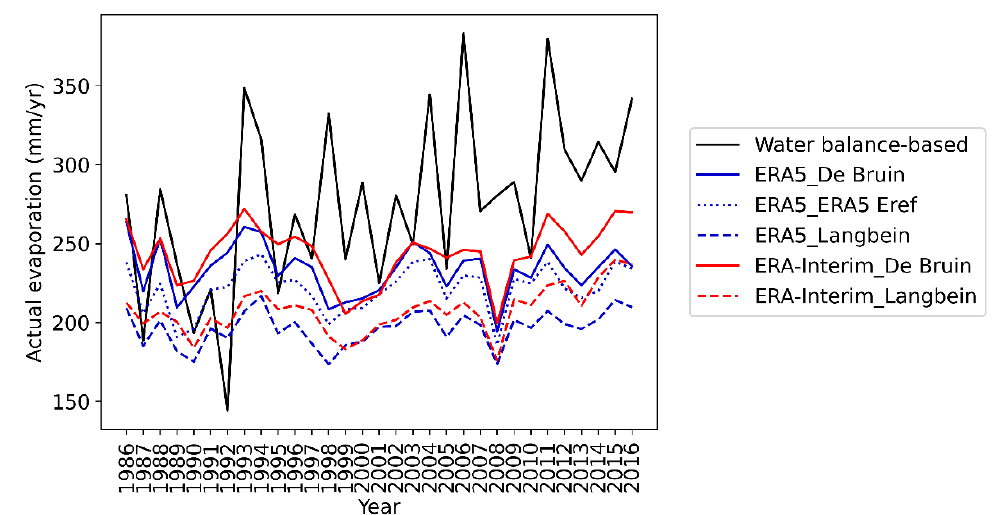
Figure 10. Estimated actual evaporation (Eact) calculated by the GlobWat model using different weather datasets and reference evaporation (Eref) methods against the observed data over Urmia Lake, Iran.